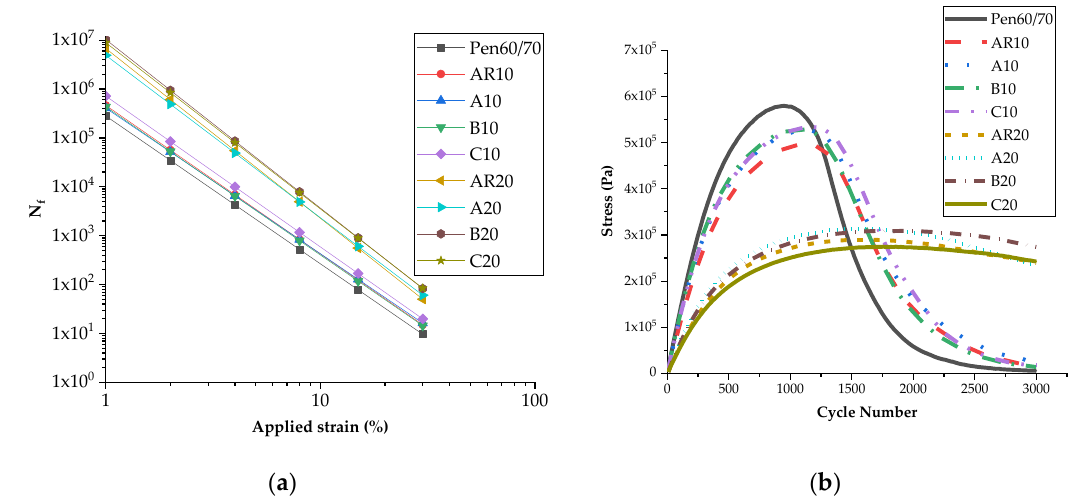
Figure 7. LAS test results: ( a ) fatigue life curves; ( b ) stress amplitude curves.